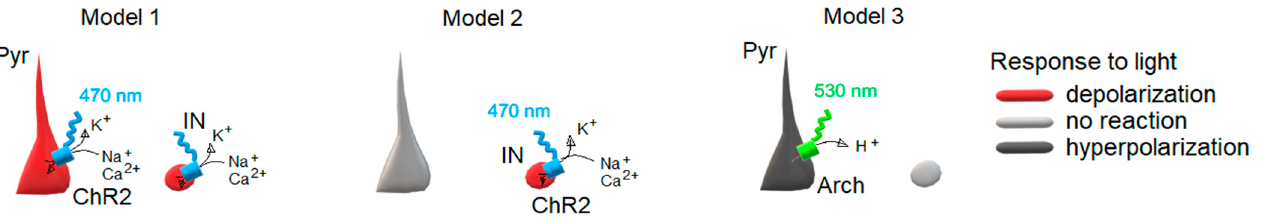
Figure 1. Genetic models used to search for a targeted antiepileptic stimulation. Model 1: activation of both pyramidal cells (Pyrs) and interneurons (INs) expressing Channelrhodopsin2 (ChR2) with 470 nm of photostimulation. ChR2 is a nonspecific cation channel that opens when exposed to light. This results in depolarization and the generation of action potentials in the neurons. Model 2: specific activation of interneurons expressing ChR2 with photostimulation. Model 3: specific hyperpolarization of pyramidal cells expressing Archaerhodopsin (Arch). Arch acts as a transporter, pumping protons out of neurons. Model 1: Thy1-ChR2-YFP line 18 mice. Both pyramidal cells and fast-spiking